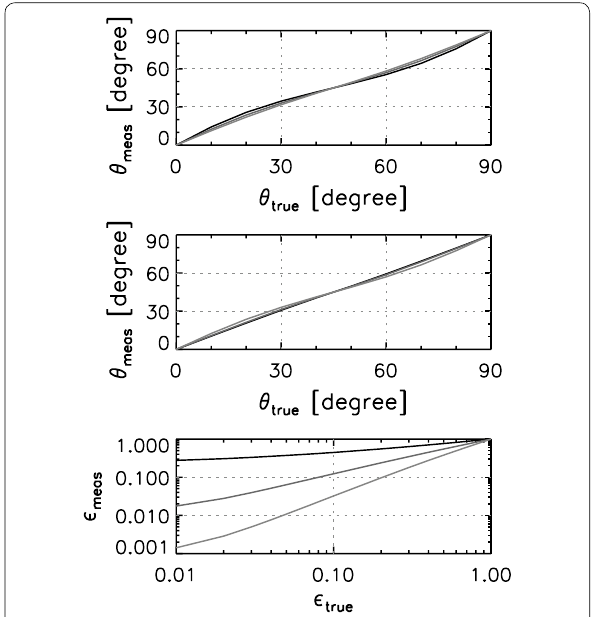
Fig. 8 Observed tilt angle of wavevector anisotropy as a function of the true tilt angle at different values of spectral slopes ( top panel ) α = 1 ( black ), α = 2 ( gray ), and α = 3 ( light gray ). The same angle rela- tion at different elliptic ratios ǫ true = 0.05 ( black ), ǫ true = 0.1 ( gray ), and ǫ true = 0.5 ( light gray ). The observed elliptic ratio as a function of the true ratio at different values of spectral slopes ( bottom panel ) α = 1 ( black ), α = 2 ( gray ), and α = 3 ( light gray )